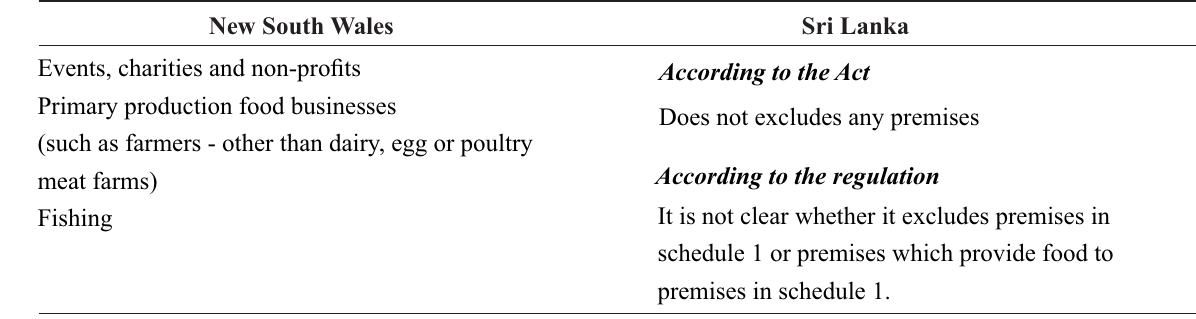
Table 3: Exclusions for